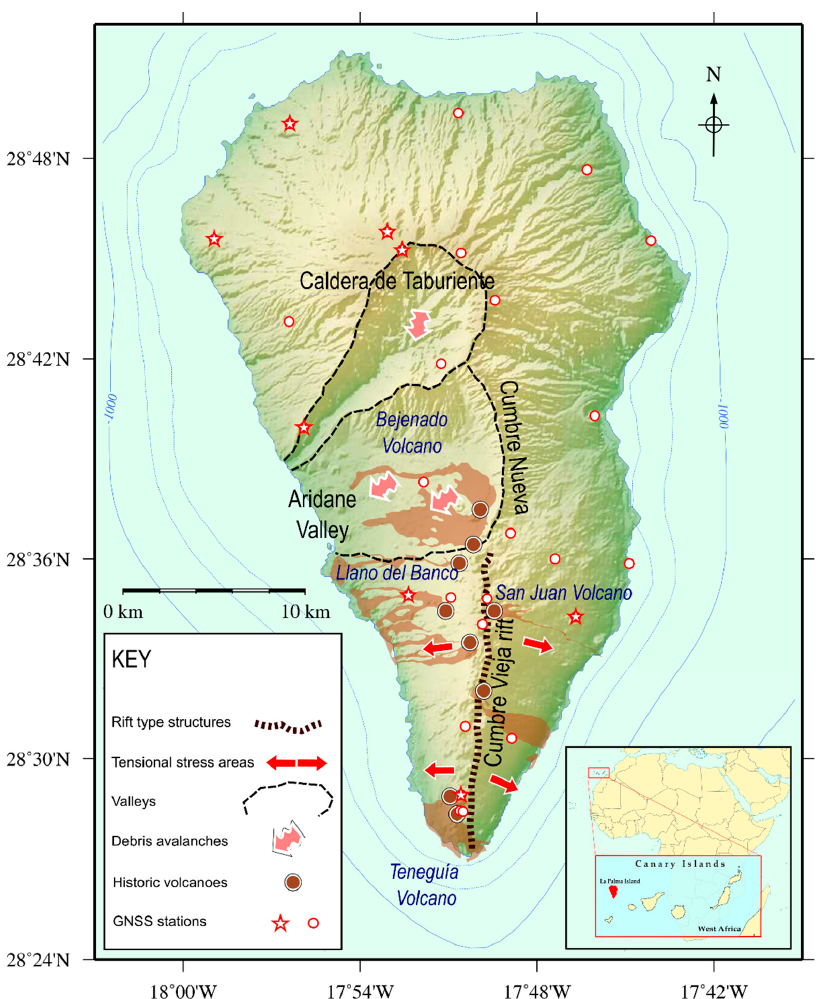
Figure 1. Location map of the Canary Islands, La Palma Island and its position relative to the West African coast (inset), as well as a map showing the structural geomorphological characteristics of La Palma Island, the main areas of interest for geodetic monitoring of the island and GNSS monitoring stations of the episodic geodetic network. Former IGN stations are shown with stars. All other new stations in the network are shown with